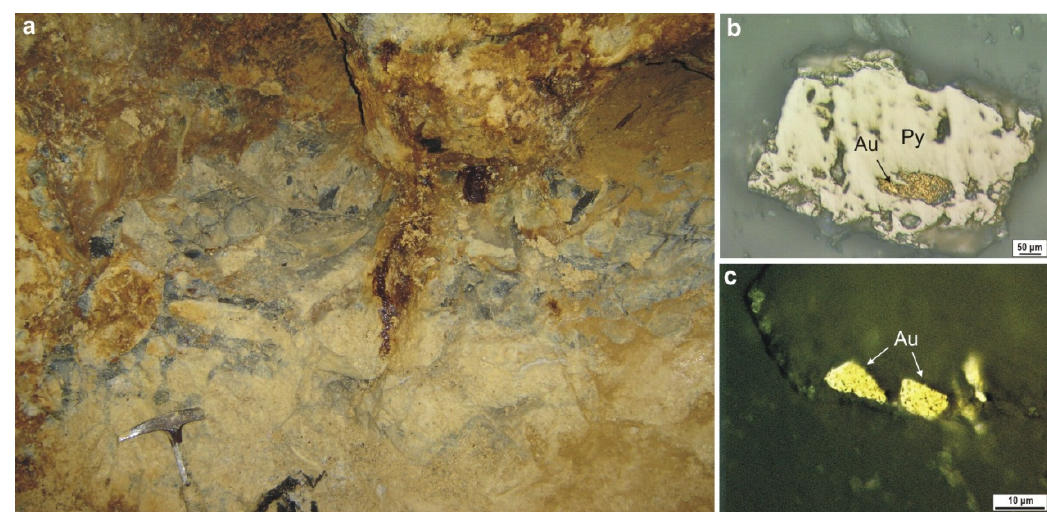
Figure 5. Underground view ( a ), and microphotographs in plane polarized light ( b , c ) of the ore body corresponding to sample 2054, the Roman mining network Cârnic 1, Lower sector; ( a ) detail of the breccia dyke ore body with angular dacite fragments and black hydrothermal cement; ( b ) native gold deposited within a pyrite crystal; and ( c ) native gold deposited within the voids of the hydrothermal cement. Abbreviations: Au: native gold; and Py: pyrite.